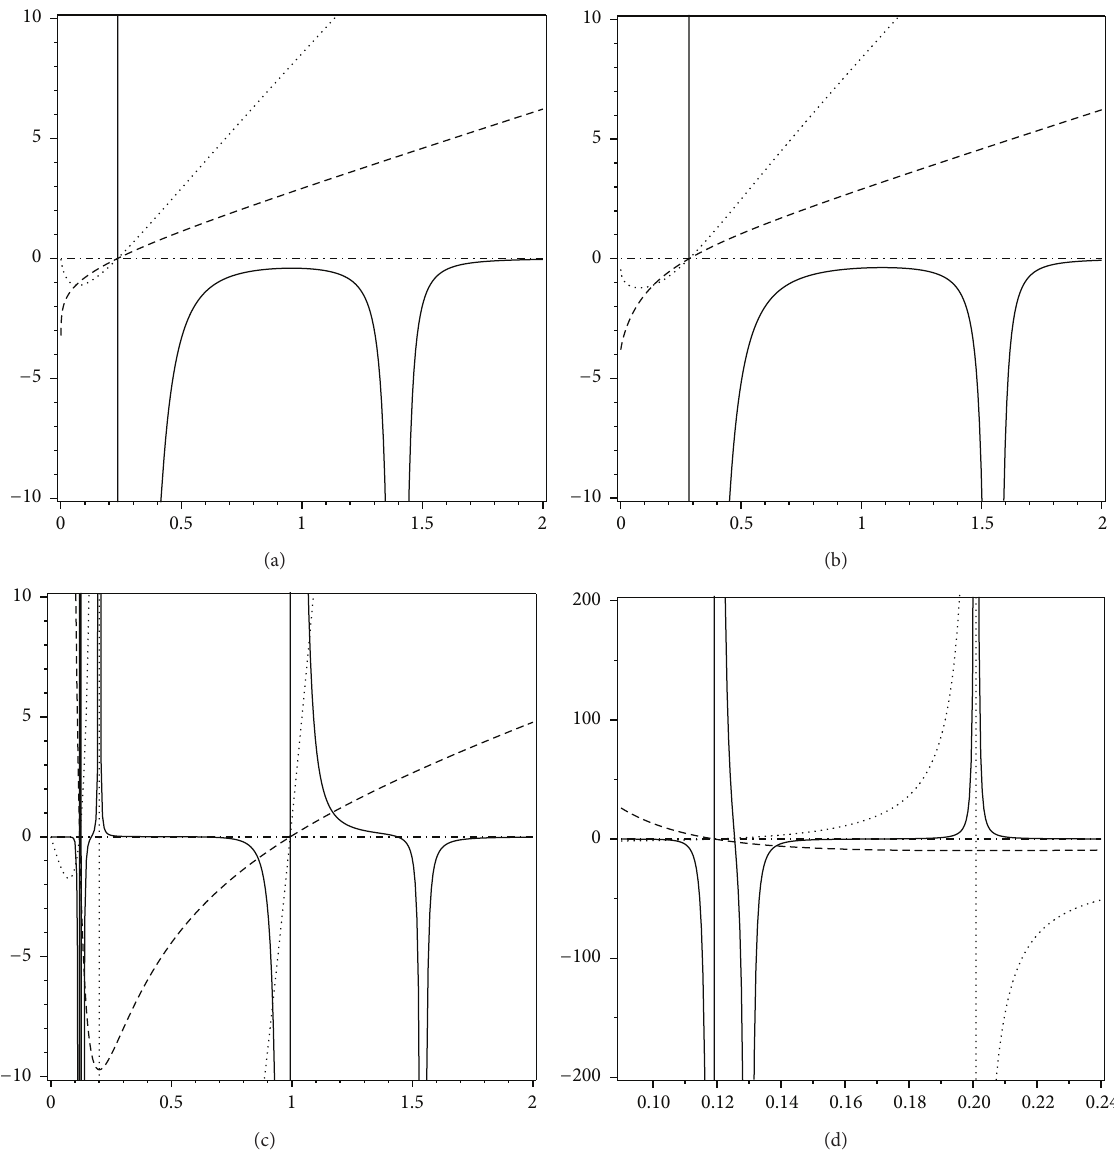
Figure 4: Quevedo Ricci scalar case II (solid line), heat capacity (dotted line), and temperature (dashed line) versus 𝑆 for 𝑙 = 1. HNED model (up-left panel) and SNED model (up-right panel): 𝑞 = 0 . 3, 𝛽 = 1. CNED model (down-left panel) and CNED model (down-right panel): 𝑞 = 1, 𝛼 = 0 . 007 (different